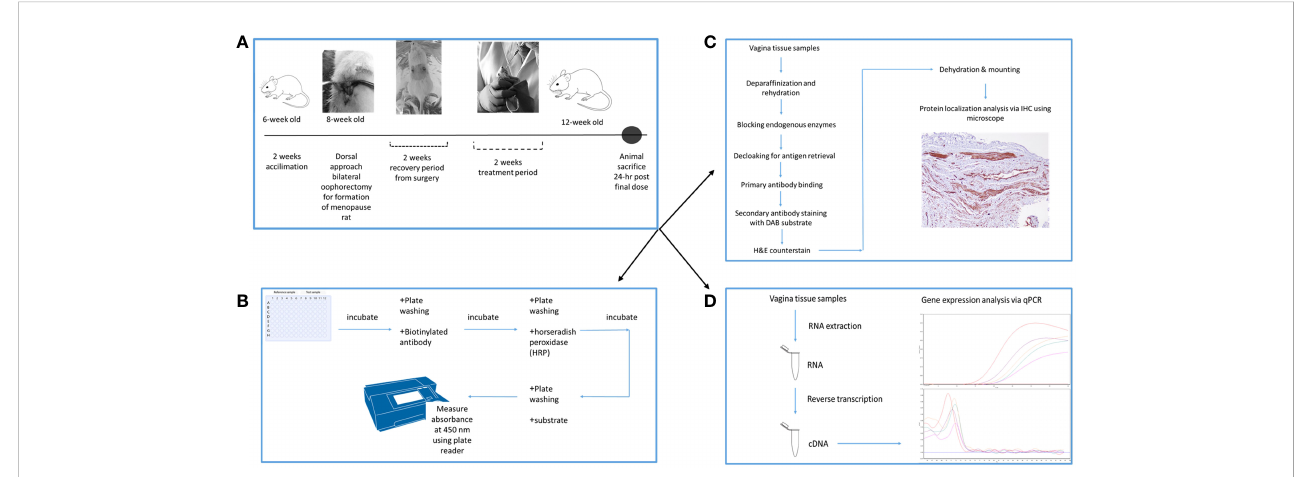
FIGURE 1 Experimental schedule and design of the experiment. (A) is the timeline for the experiment, depicting the period of bilateral oophorectomy surgery and treatment period. (B) is the protocol fl owchart for ELISA estrogen hormone analysis. (C) is the protocol fl owchart for protein localization in the vaginal tissues. (D) is the protocol fl owchart for the mRNA expression analysis in the vaginal tissues using